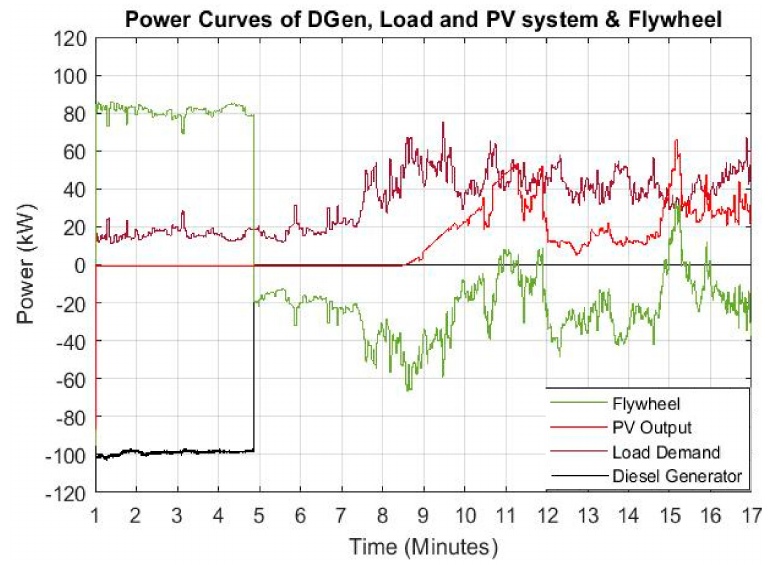
Figure 25. Combined power curves of Flywheel, DGen and PV